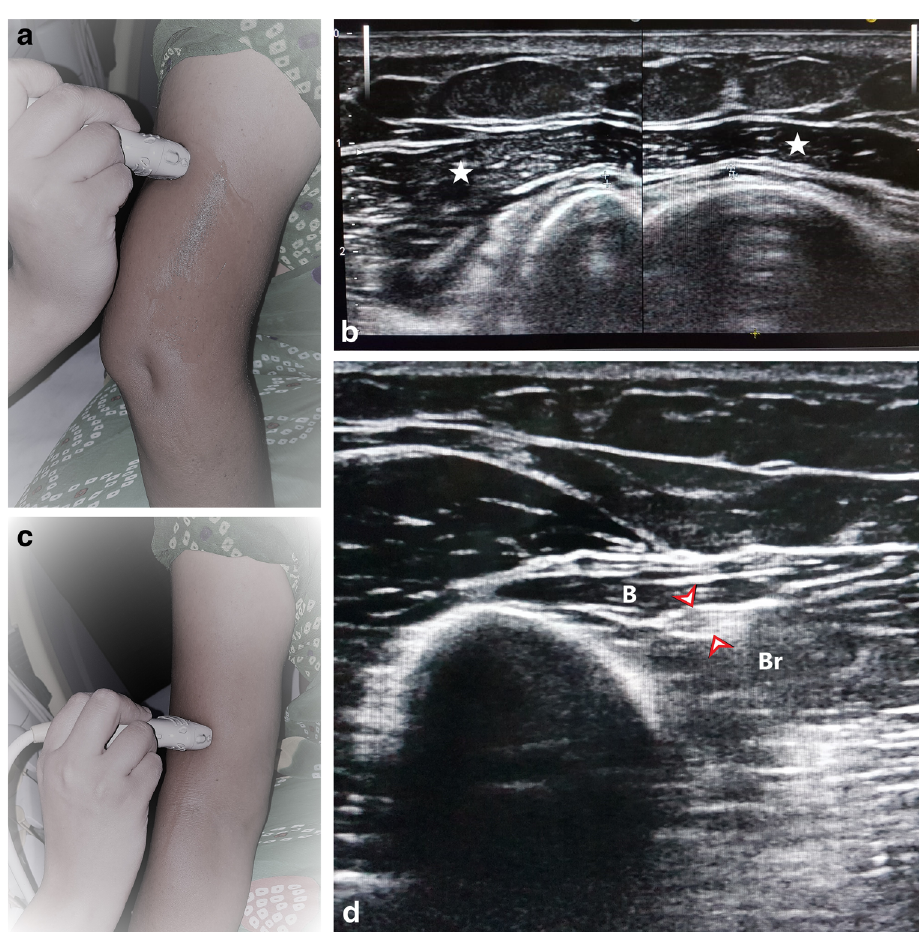
(ECRL) and extensor carpi radialis brevis (ECRB). This too is